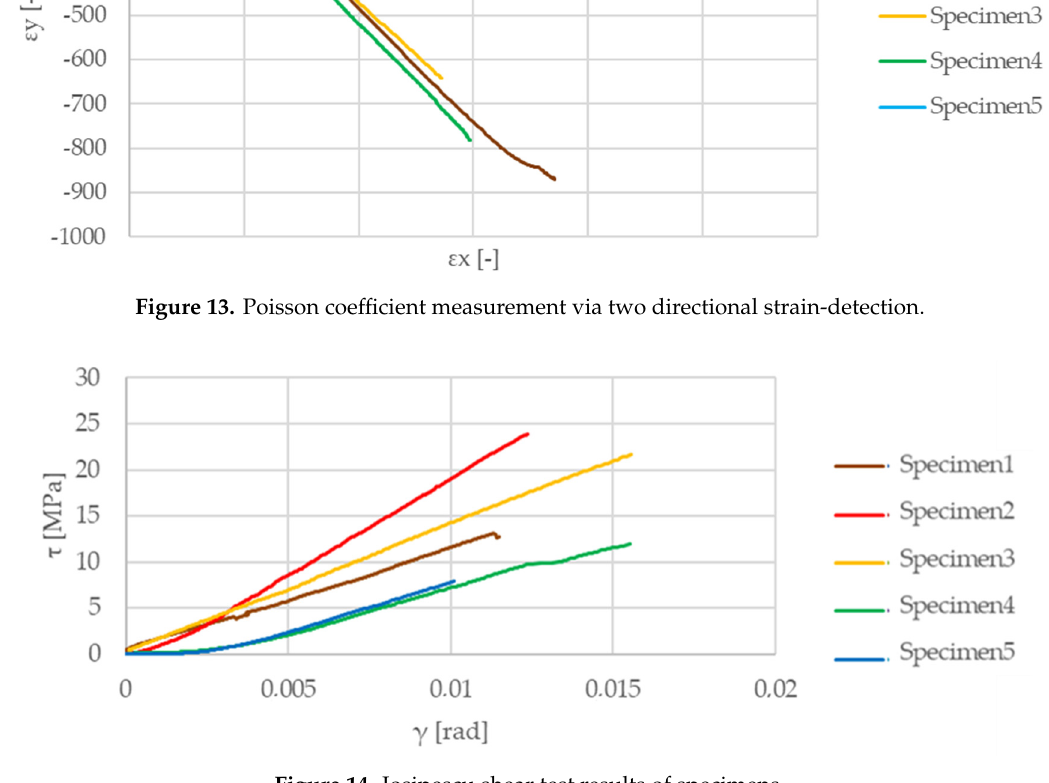
Figure 14. Iosipescu shear test results of specimens. Table 2. Properties of the matrix component group.